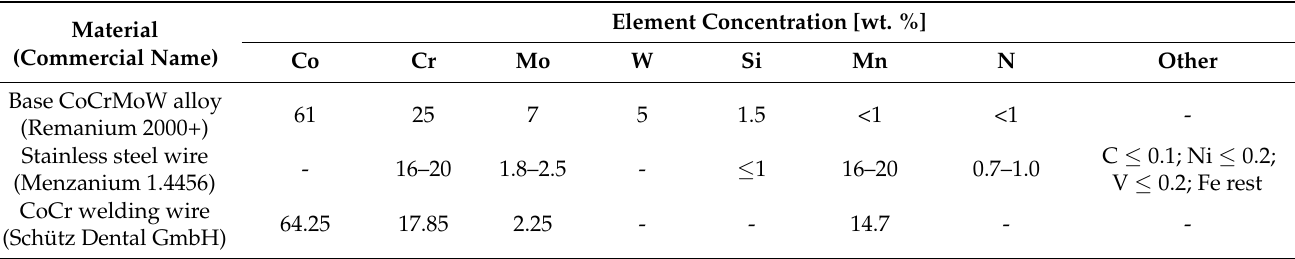
Table 1. Chemical compositions of the materials used.